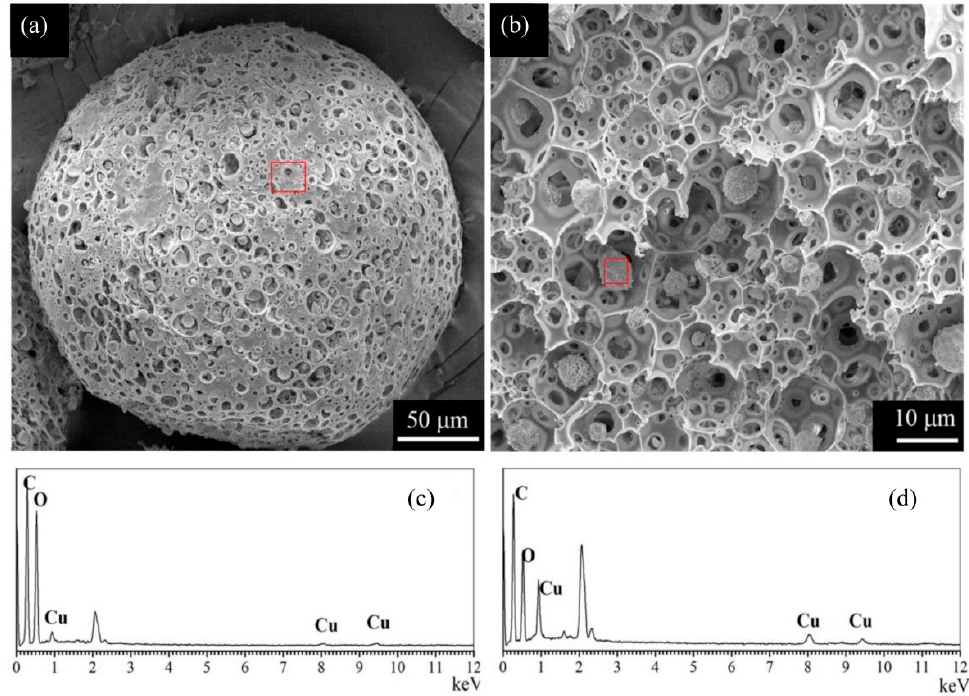
Figure 4. ( a , b ) SEM images of CMC/CA microsphere. ( c , d ) The corresponding EDS spectra of CMC/CA microsphere. ( a , c ) denotes the surface structure while ( b , d ) were the cross-section structure of the microspheres.